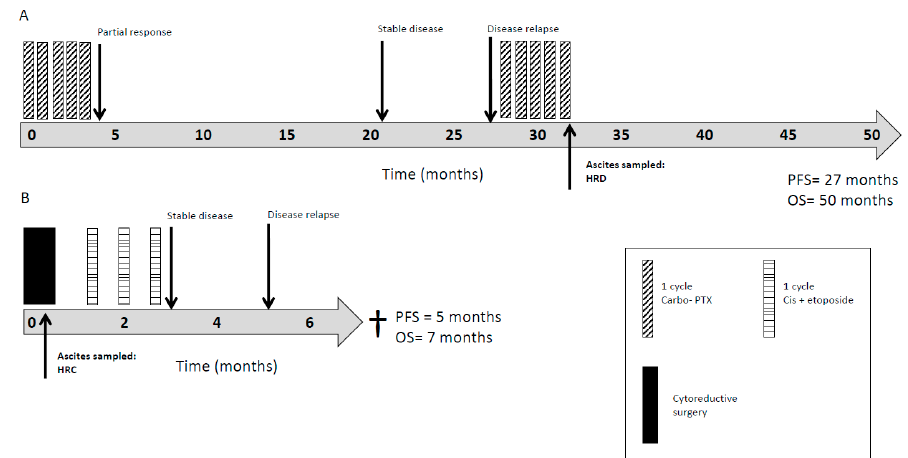
Figure 5. Patient survival in HRD vs. HRC. Clinical course of ( A ) HRD patient PA022 (peritoneal